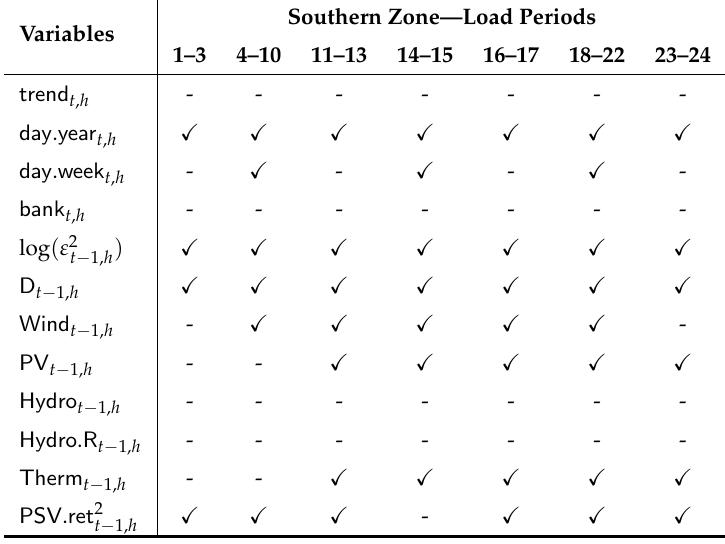
Table 4. Selected variables for the predictive models for the conditional variance of price in the southern zone.